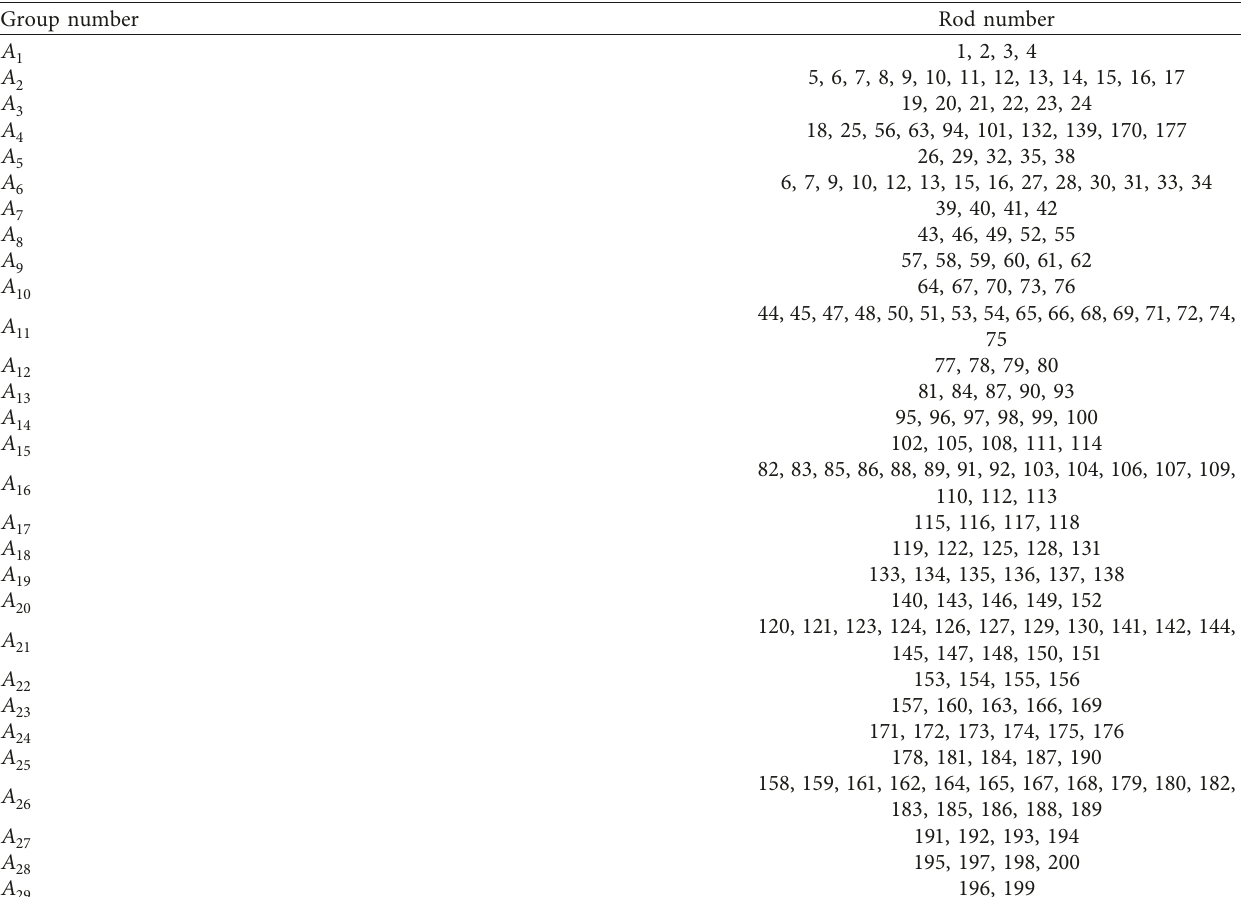
Table 12: 200 bar plane truss structure grouping.